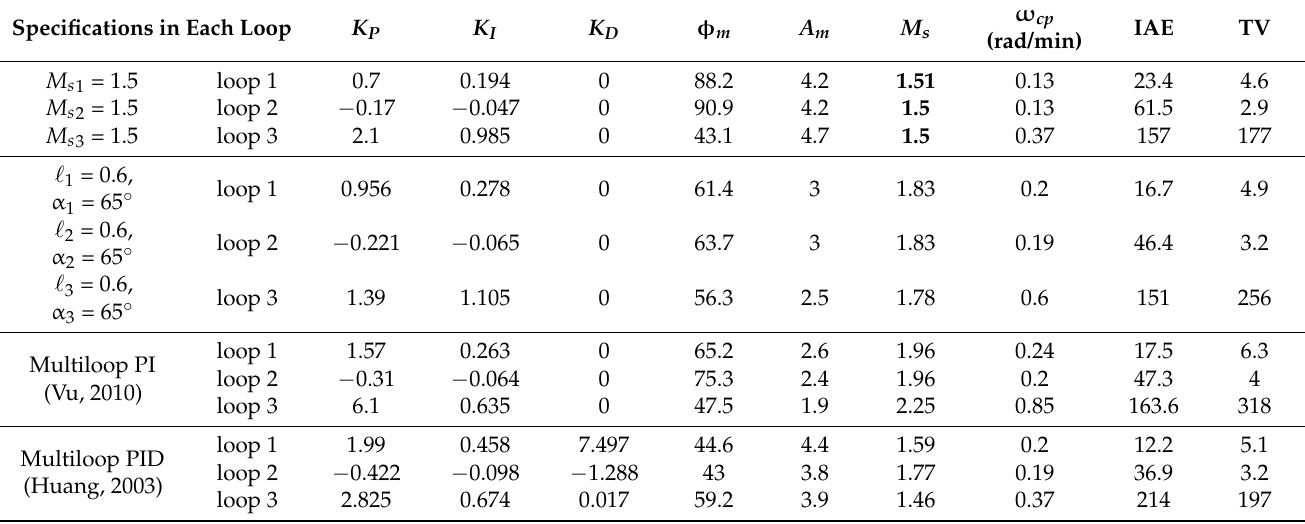
Table 2. Proposed multiloop PID controllers and their corresponding robustness and performance indices in example 2. Specifications in Each